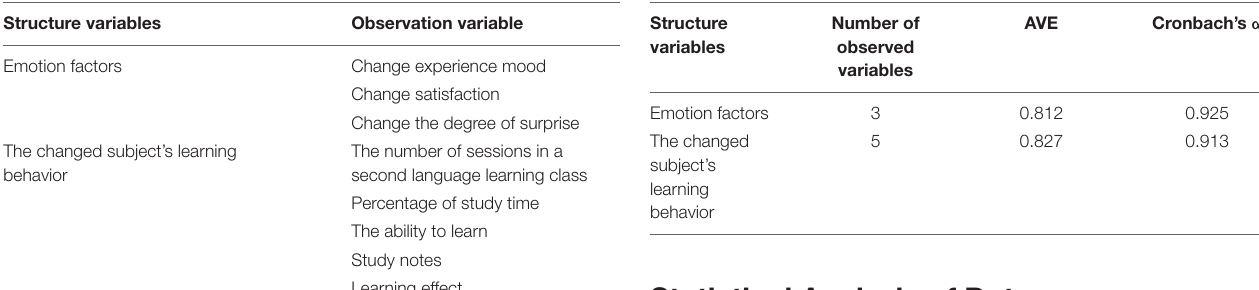
TABLE 5 | The observed variables of emotion factors and learning behaviors. TABLE 6 | The reliability and validity test results of structural variables.